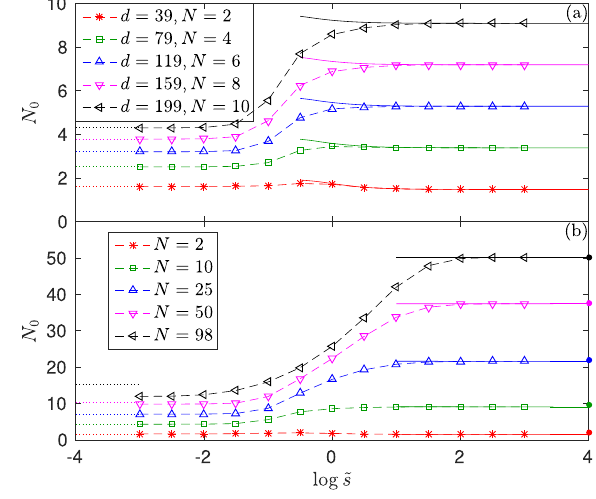
N ð ~ s Þ for fi xed 0 as a function of log low-density n ≃ 0.05 and various site numbers d . b N 0 as a function of log ð ~ s Þ , various numbers of particles N , and a fi xed number of sites d = 199. The dots on the vertical axis represent N (1 − n ). Symbols: results from density matrix renormalization group calculations, dashed lines: a guide for the eye, solid lines: analytical result (Supplementary equation S28). The dotted lines mark the asymptotic values for fi nite N , s = 0, d → ∞ obtained by the exact numerical calculation of a Toeplitz determinant 39